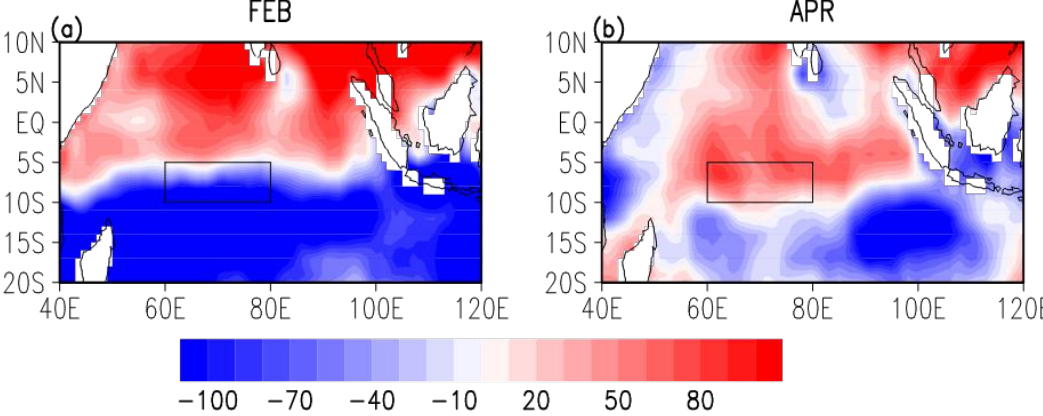
Figure 6. Freshwater flux anomalies. ( a ) Monthly mean freshwater flux in February ( a ) and April ( b ) from 2005 to 2014. (Unit: cm/yr). The box (in black line) denotes the SSSAs ESF area ( 60° E – 80° E, 10° S – 5° S).